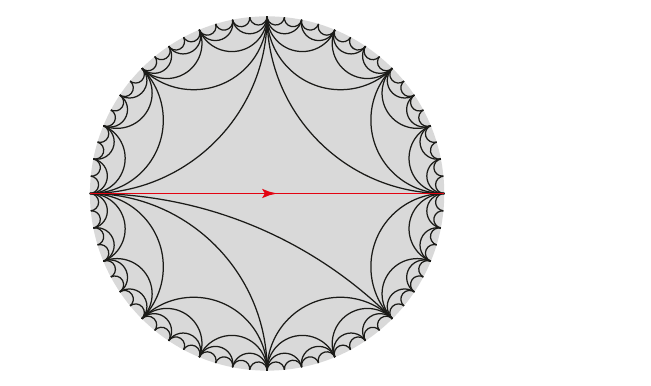
Figure 7 . The standard dyadic tessellation with distinguished oriented edge.